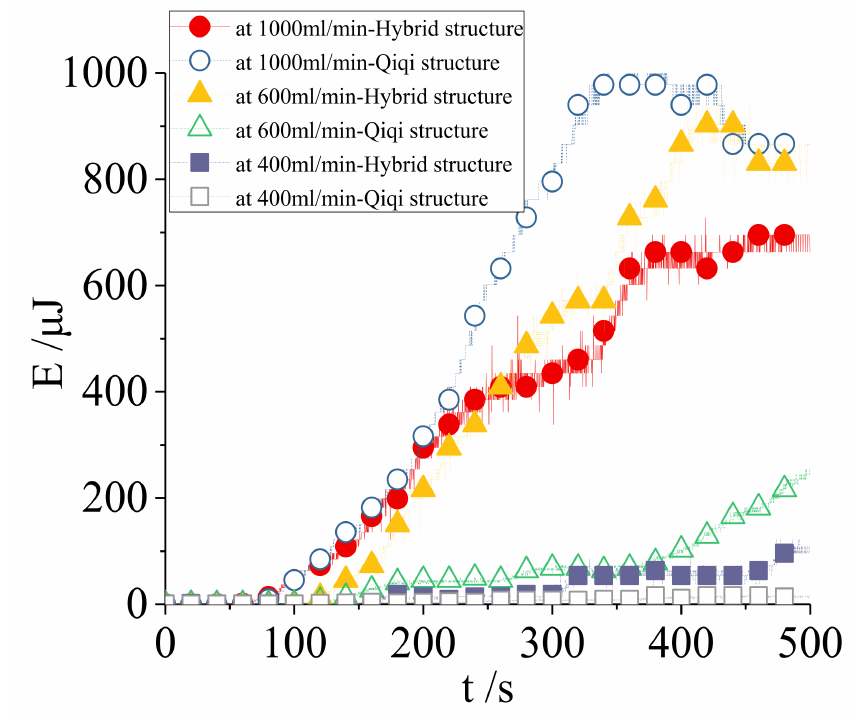
Figure 12. Electrical energy stored under different water flow